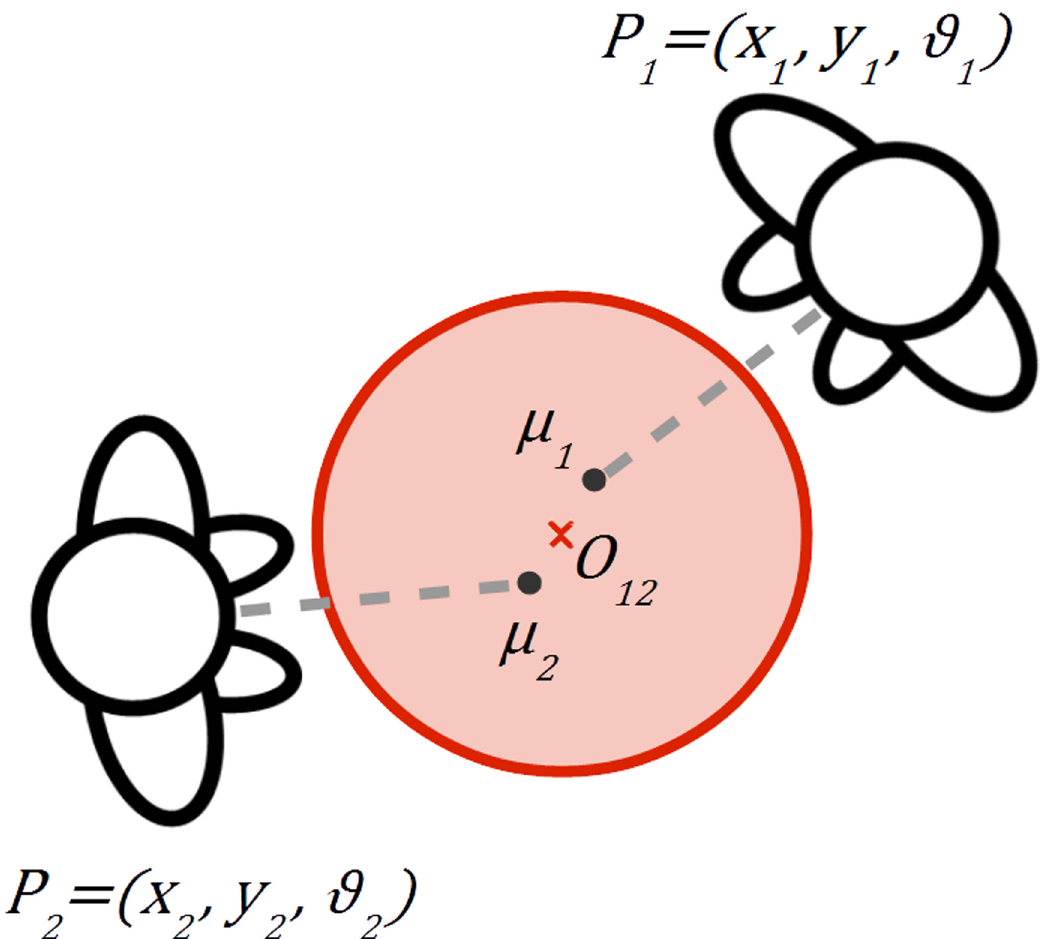
Fig 5. Schematic representation of the problem formulation. Two individuals facing each other, the gray dot representing the transitional segment centre, the red cross being the o-space centre and the red area the o-space of the